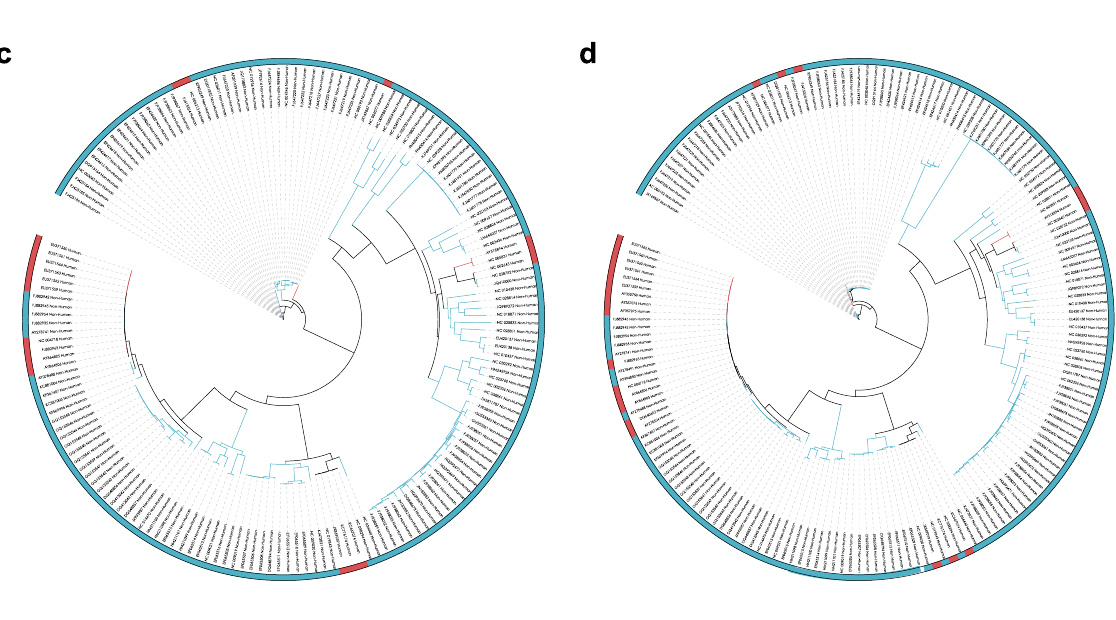
Figure 1. DeepHoF outperforms BLAST. ( a ) Average ROC curves and AUC values of DeepHoF and BLAST. DeepHoF performs better than BLAST on average AUC of five host types. ( b ) Comparison of human host likelihood scores predicted by DeepHoF between human-infecting and non-human-infecting coronaviruses on human. The former performed higher probabilities than the latter (two-sided unpaired Welch Two Sample t test, t (43.843) = 8.265 and t (38.016) = 4.674, p values = 1.732 × 10 –10 and 3.657 × 10 –5 . ***: p value < 0.0001, t values and degrees of freedom were presented as t (df) ). ( c , d ) Phylogenetic analyses of whole genomes and S genes of coronaviruses respectively. Maximum-likelihood phylogenic trees were built by RAxML 39 with 1000 bootstrap replicates and visualized with iTOL 41 . There were clear non-human-infecting gaps between closely related human-infecting coronaviruses in the phylogenetic trees for either whole genomes or S genes. For some human- infective viruses, their closest neighbors in phylogeny were non-human-infective ones (red: human-infective coronaviruses; blue: non-human-infective